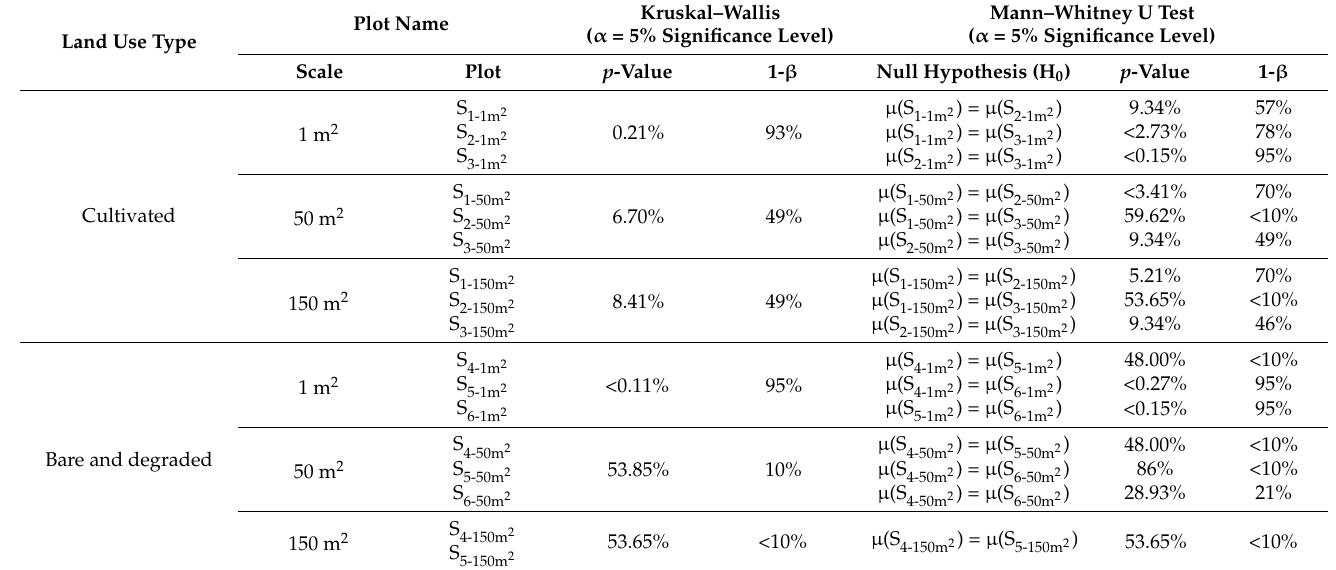
Legend : µ refers to the mean of the distribution of soil loss values measured at a given scale. Table 5. Analysis of the effect of the plot location on soil loss values in the Tougou